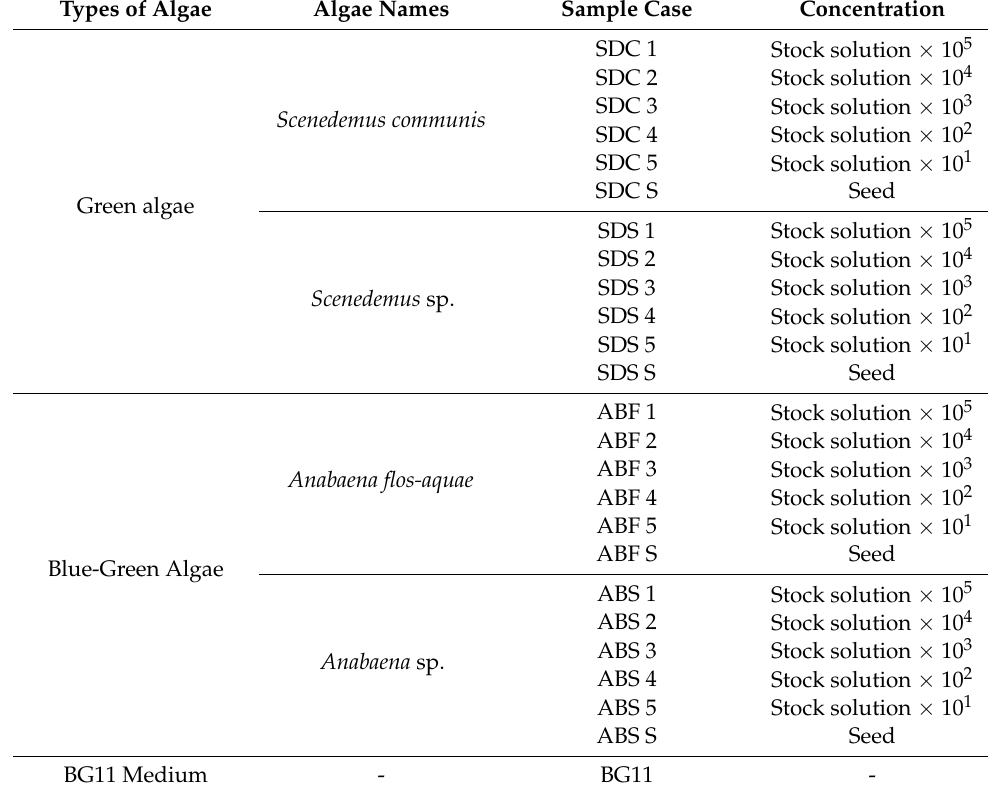
Table 1. Algae culture media sample case.